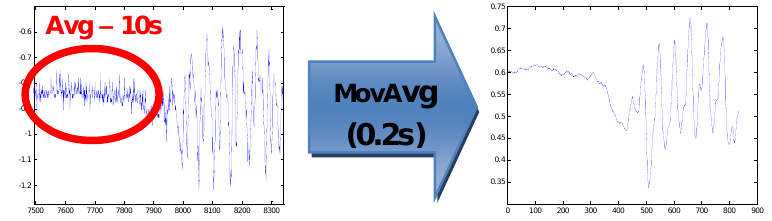
Figure 6. Preprocessing of the acceleration signals–subtracting the local offset value and averaging the